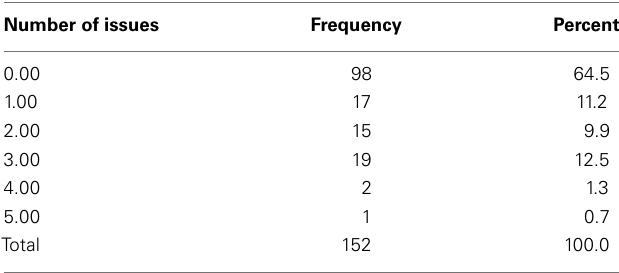
Table 2 | Number of people with a discrepancy between System Scoring and Clinician Scoring IVR Digit Span Forward.